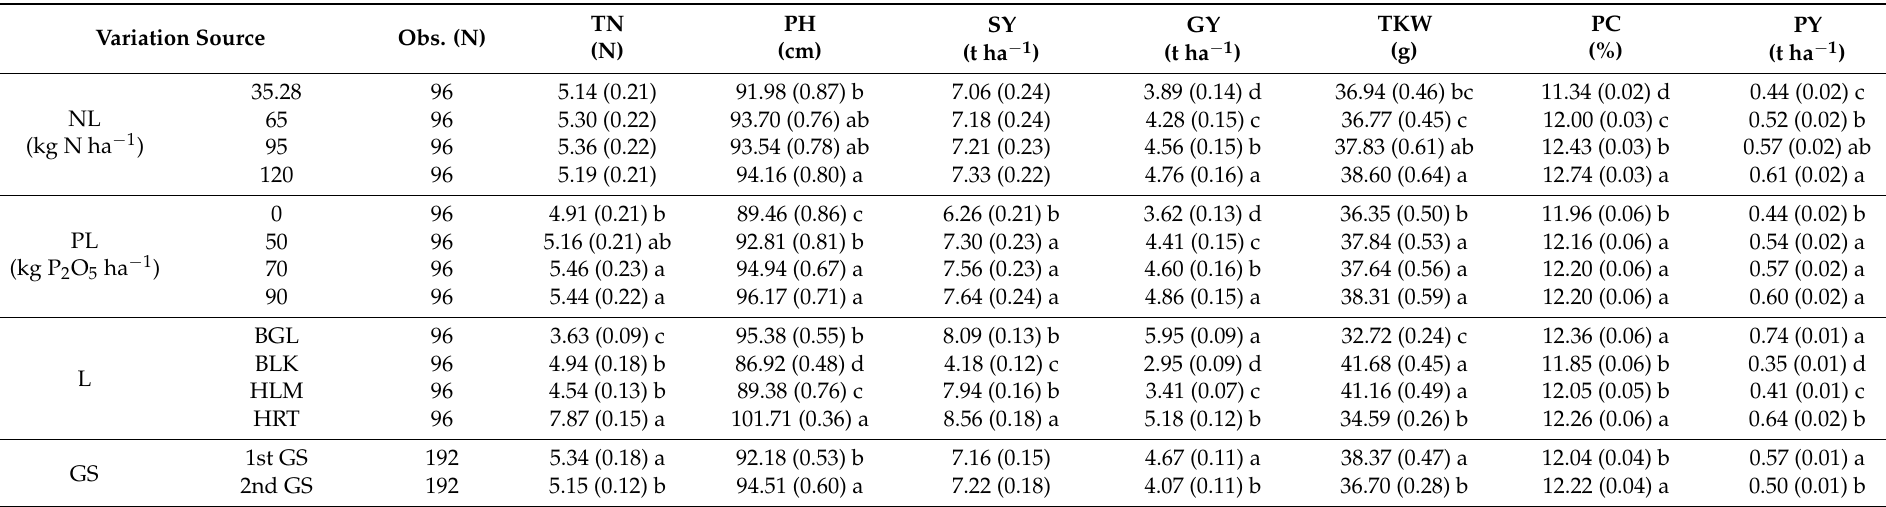
Table 3. Mean of tiller number (TN), plant height (PH), grain yield (GY), straw yield (SY), harvest index (HI), 1000 kernel weight (TKW), protein concentration (PC), and protein yield (PY) parameter results, considering the factors, growing season (GS), location, nitrogen (NL), and phosphorus (PL) fertilization treatment. The lowercase letter shows the Tukey HSD post-hoc test results, and the value inside parentheses represents standard